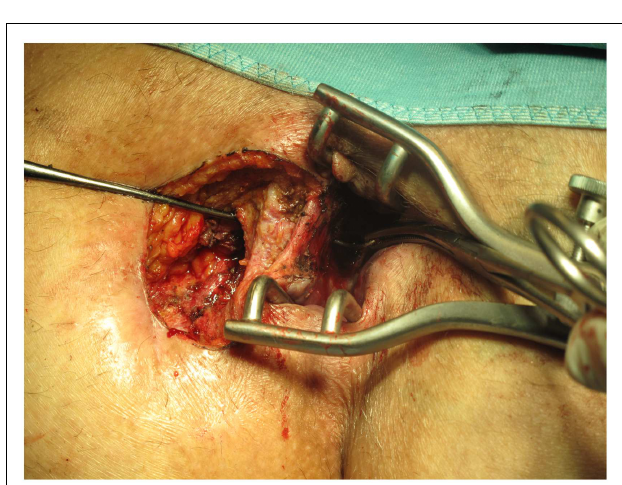
FIGURE 4 | Clinical picture after limited or partial removal of the complex anal fistula and preservation of the internal and external sphincter muscle .